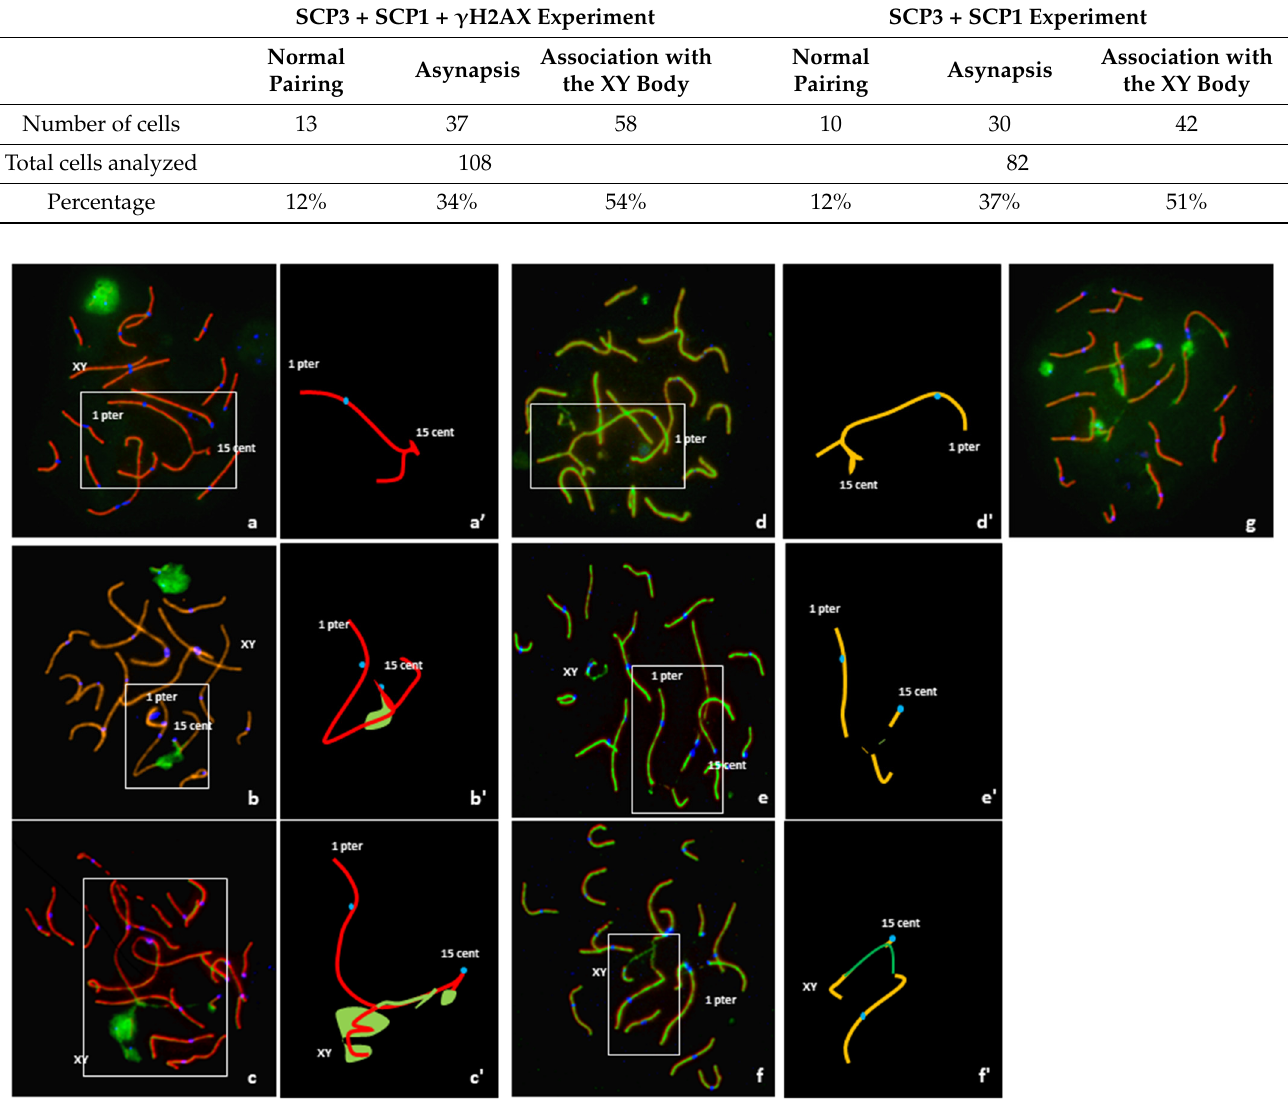
Table 1. Number of cells analyzed and percentage of the different pairing configurations observed in the immunocytology experiments.